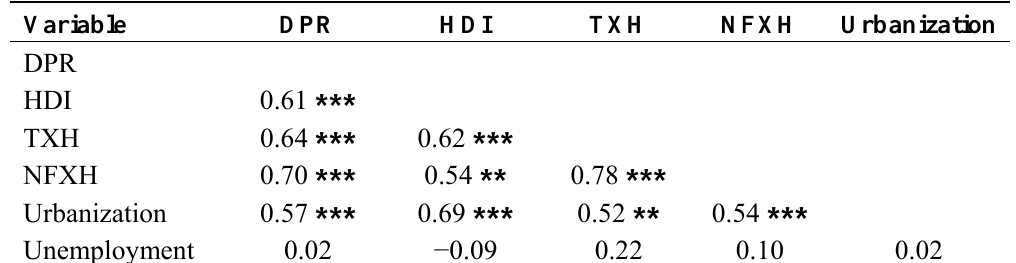
Table 3. Pairwise correlations between dentists to population ratio and various measures of social